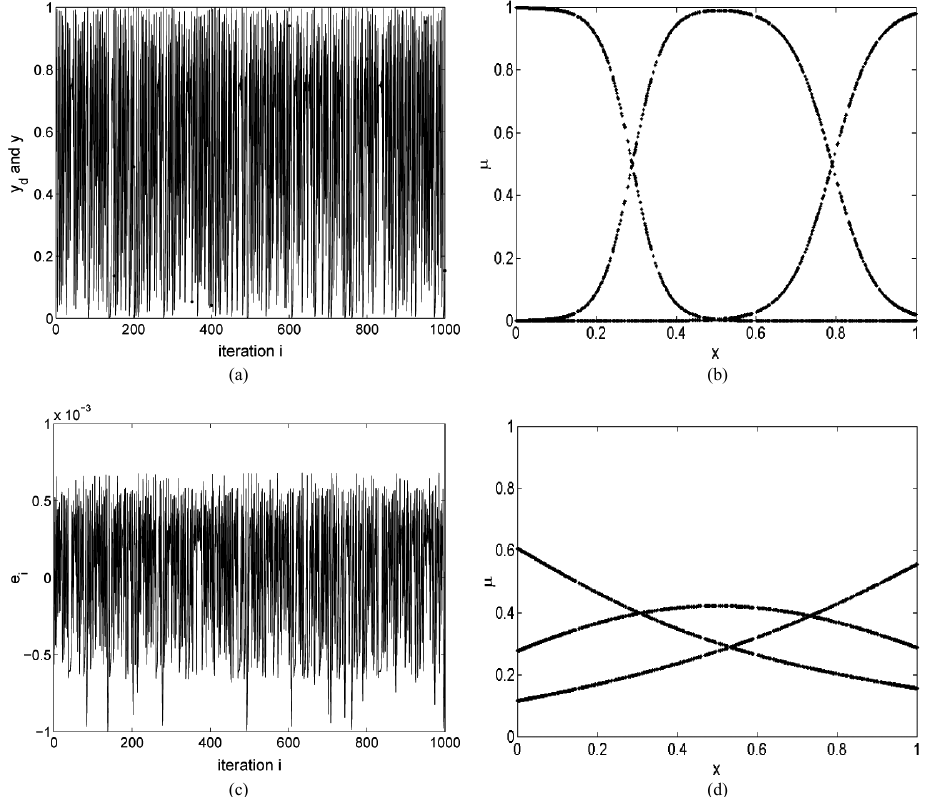
Fig. 3. T-S Fuzzy modeling of input-output data pairs. (a) Input-output data and fuzzy model. (b) Initial membership functions. (c) Modeling error. (d) Final membership